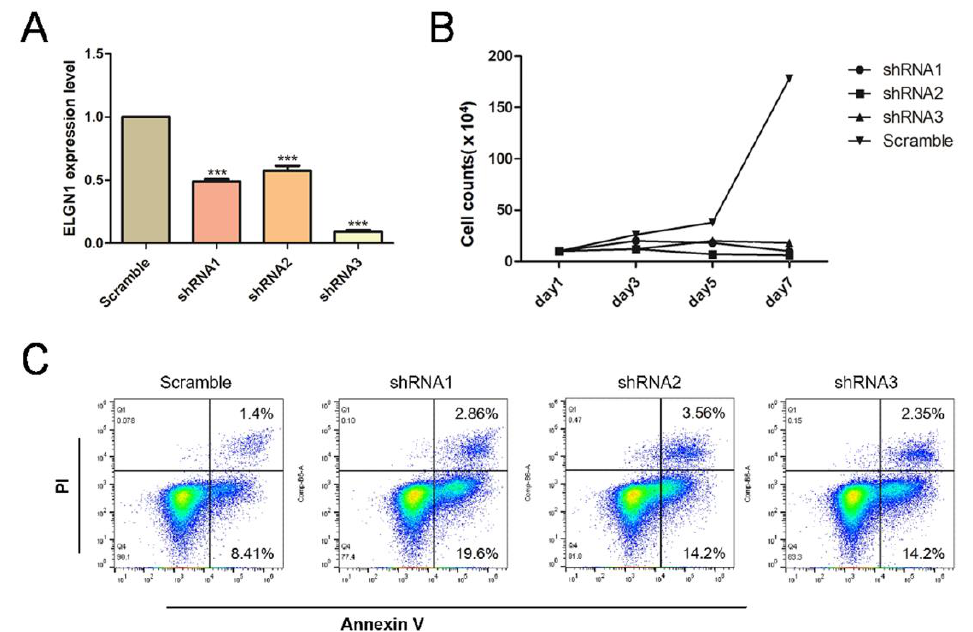
Figure 4. Effect of EGLN1 knockdown on the growth of the CLL cell line MEC-1. ( A ) Quantitative PCR (qPCR) determination of the knockdown efficiency of the three short hairpin RNAs (shRNAs) on EGLN1 gene knockdown in MEC-1 cells. All three shRNAs caused effective knockdown in MEC-1 cells (*** means p ≤ 0.001). ( B ) Growth curves of the shRNA knockdown group and the control group. The growth rate of the knockdown group was significantly lower than that of the control group. ( C ) Proportion of apoptotic cells in the knockdown and control groups. The percentage of early apoptotic cells in the knockdown group was higher than in the control group.